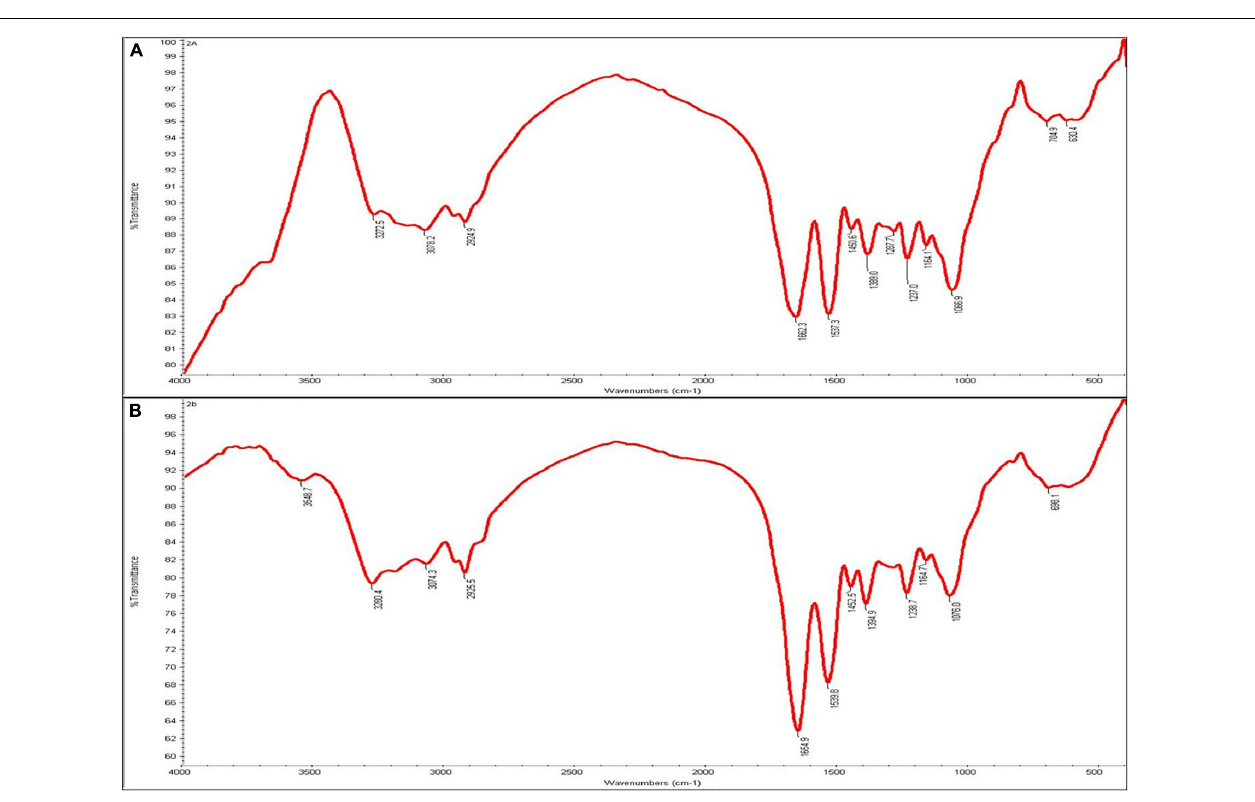
FIGURE 3 | Infrared spectra of (A) Ochrobactrum intermedium BB12 grown in nutrient broth (control) and (B) media amended with 25 mg L − 1 Cd